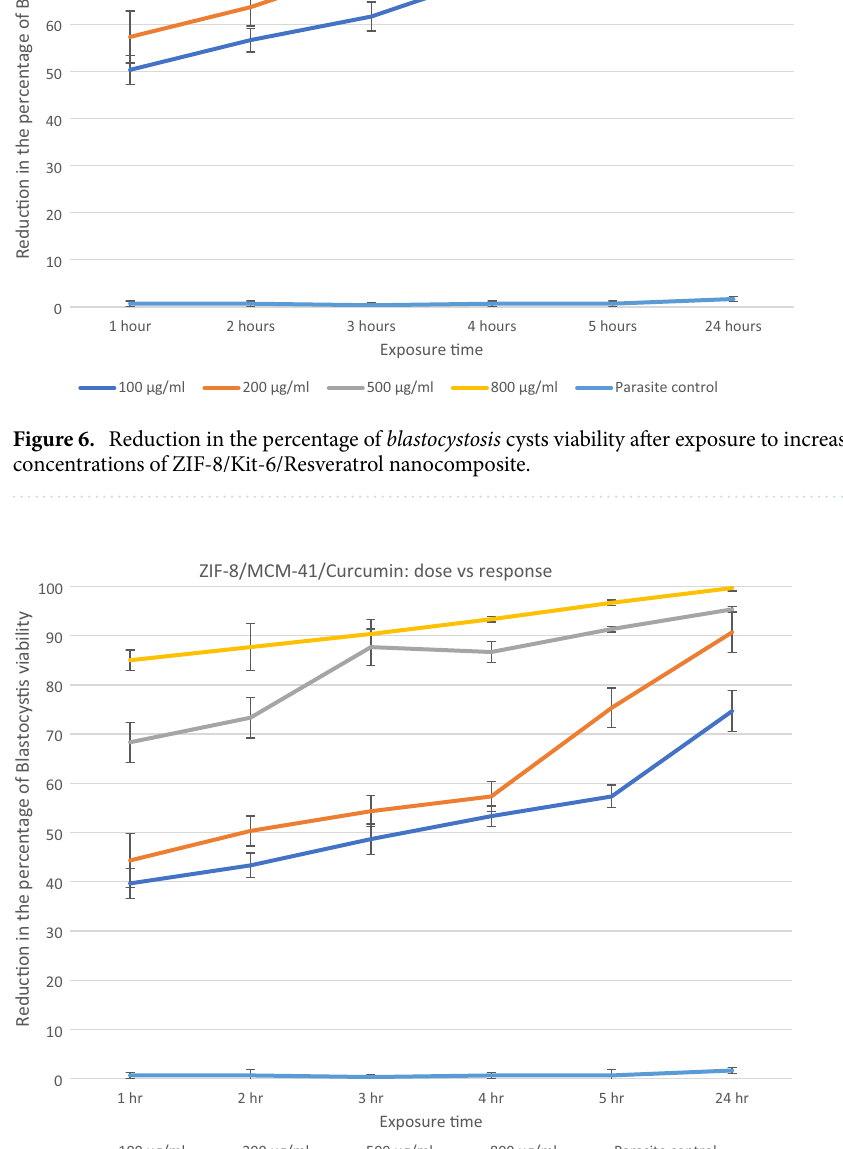
Figure 7. Reduction in the percentage of blastocystosis cysts viability after exposure to increasing concentrations of ZIF-8/MCM-41/Curcumin